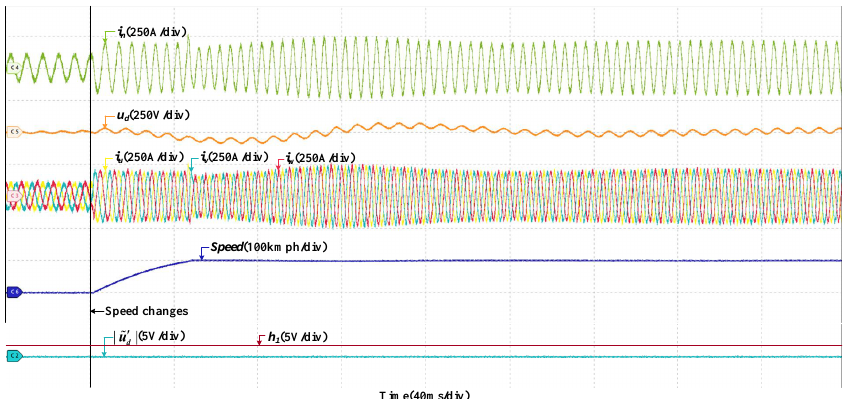
Figure 6. HIL results when the train speed